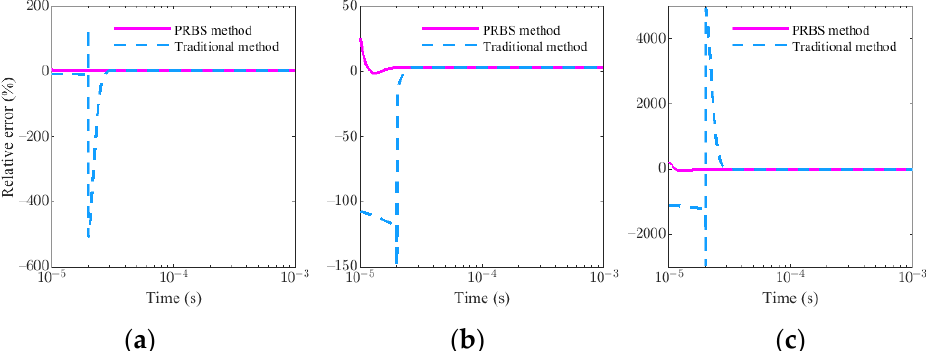
Figure 11. The comparison of response relative errors between PRBS method and traditional method in different primary field coefficient K: ( a ) K = 1 × 10 − 5 . ( b ) K = 1 × 10 − 4 . ( c ) K = 1 × 10 − 3 .